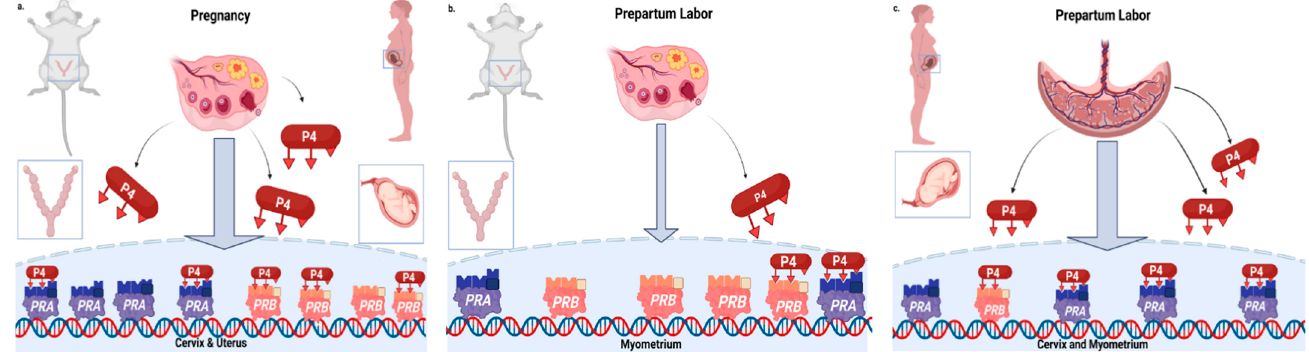
Figure 1. A cross-species comparison of the importance of progesterone (P4) for pregnancy and parturition. ( a ) In mice and women, sustained increasing production of progesterone (P4) from the corpus luteum of the ovary is essential to establish and maintain pregnancy. P4 production in women shifts to the placenta in the first trimester of pregnancy. Most physiological effects of P4 are mediated by two classic genomic nuclear progesterone receptor isoforms, PR-A and PR-B, respectively. ( b ) P4 declines in the circulation just before labor in prepartum mice. This period comes after the cervix ripens while P4 concentrations are near or at peak [24]. ( c ) In prepartum women, P4 re- mains near peak or increases in the circulation until birth occurs. Thus, cervix ripening and labor reflect a functional withdrawal of the effects of P4 for parturition in women, while in mice there appears to be a functional loss of response to P4 for ripening of the cervix followed by an actual loss of P4 for labor and birth. Adapted from “ Molecular Pathway and Mouse Phenotype (Layout)” , by BioRender.com (2022). Retrieved from https://app.biorender.com/biorender-templates (accessed on 20 June 2022).